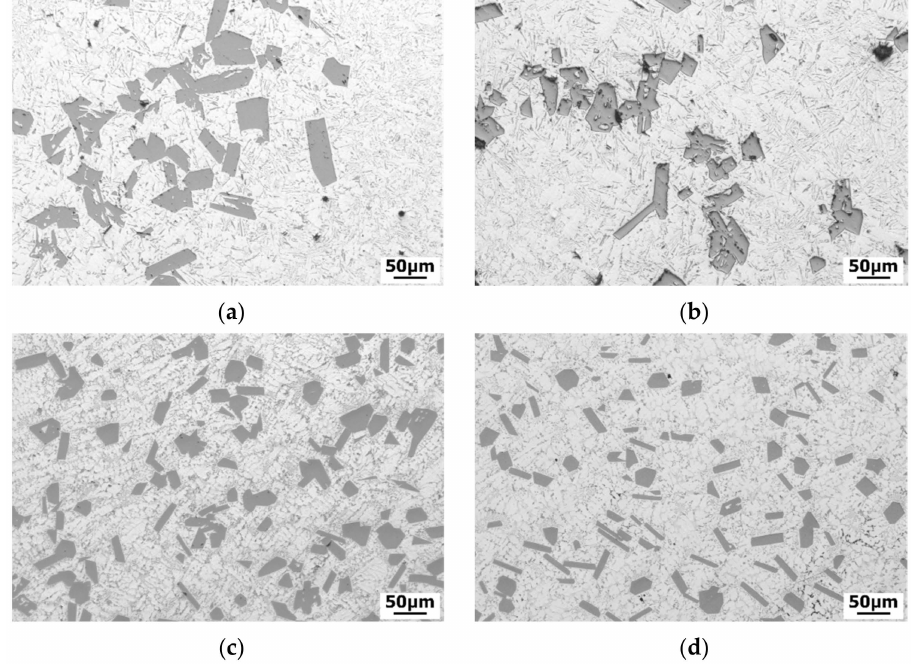
Figure 5. Microstructures of ( a ) B390-0.5Bi ( b ) B390-1.0Bi ( c ) B390-0.05P and ( d )